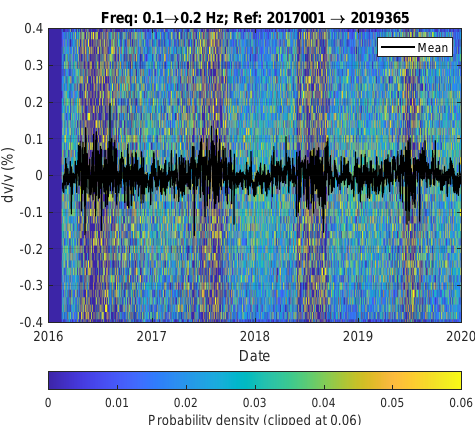
Figure 10. Time-lapse seismic velocity change retrieved from seismic ambient noise within frequency bandwidth [0.1 0.2] Hz, using the coda of the cross-coherence of horizontal (RR, RT, TR, TT) compo- nents between 78 receiver combinations. The background colors show the probability distribution of 312 estimates from dark blue (low probability) to yellow (high probability), while the black line shows the average velocity